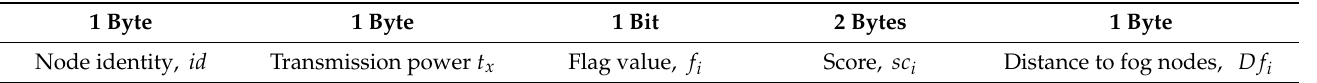
Table 1. Format of a routing